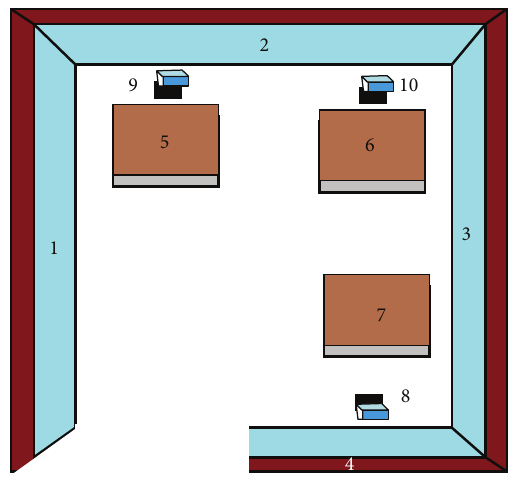
Figure 1: Sample environment for showing the AVL tree creation.